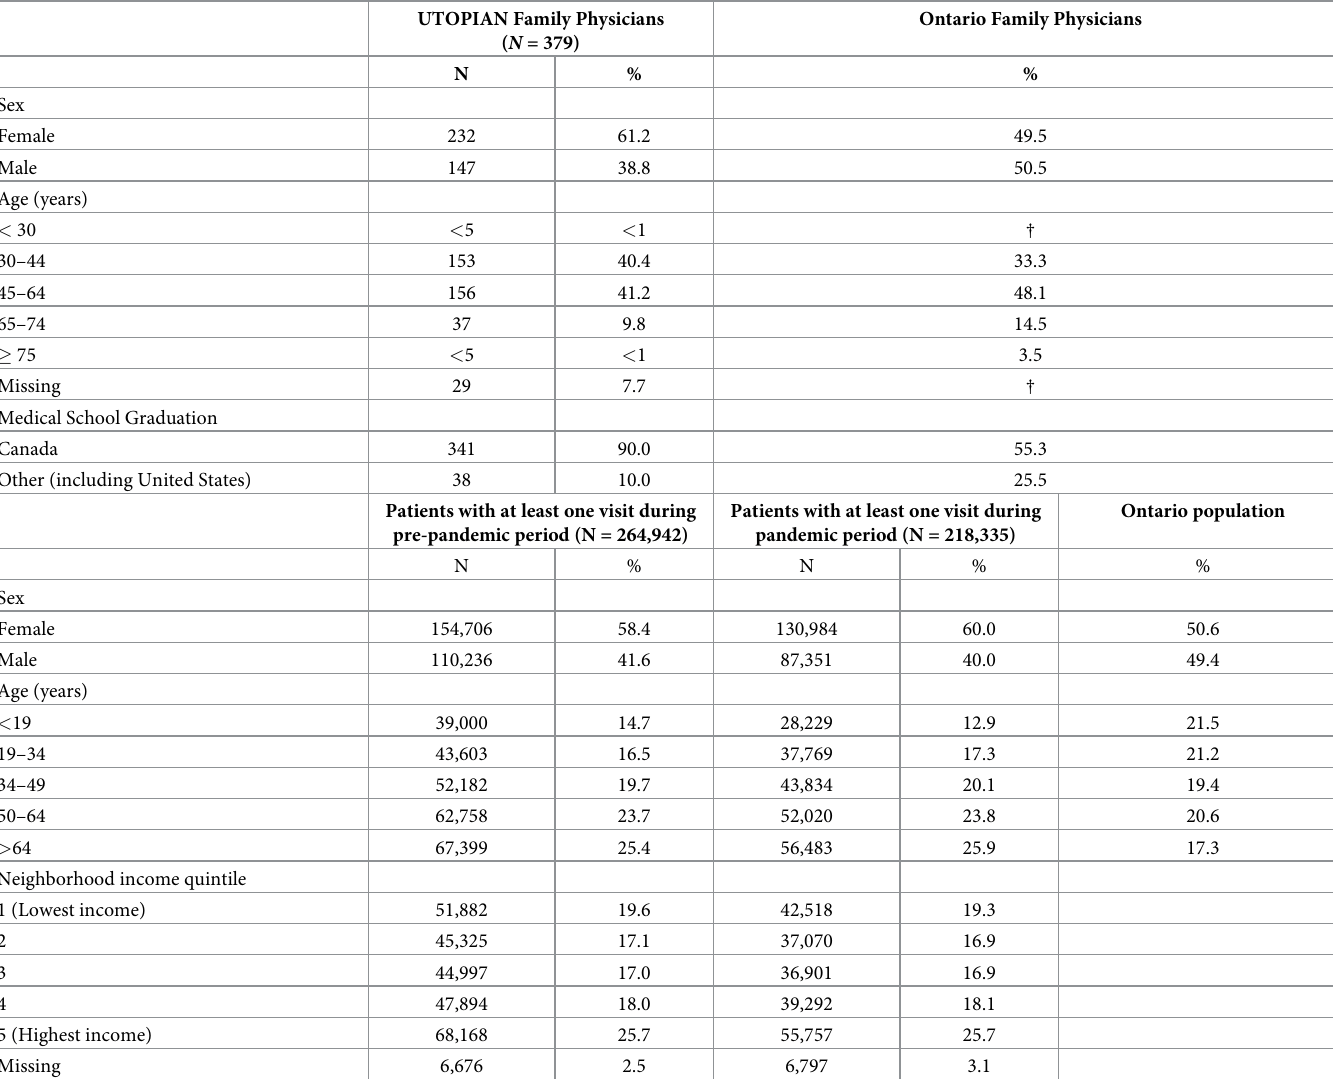
Table 1. Physician and patient